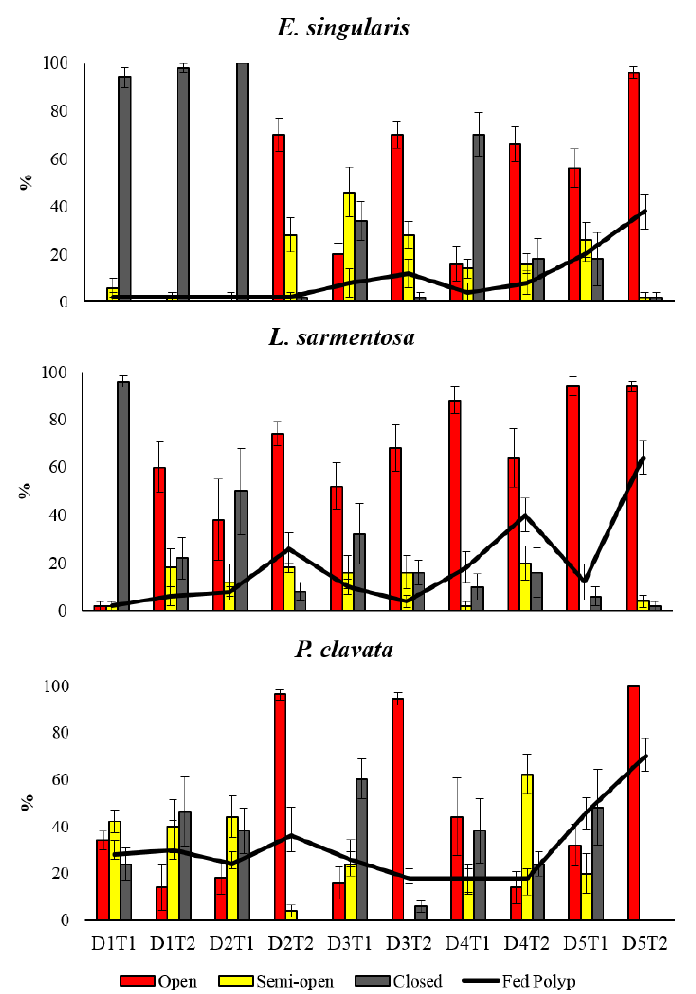
Figure 3. The polyp expansion and nutritional status of the three species.